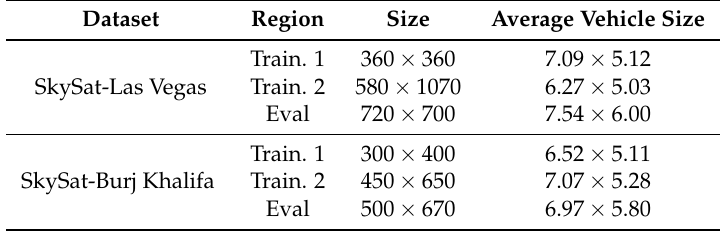
Table 1. Detailed information for the datasets.